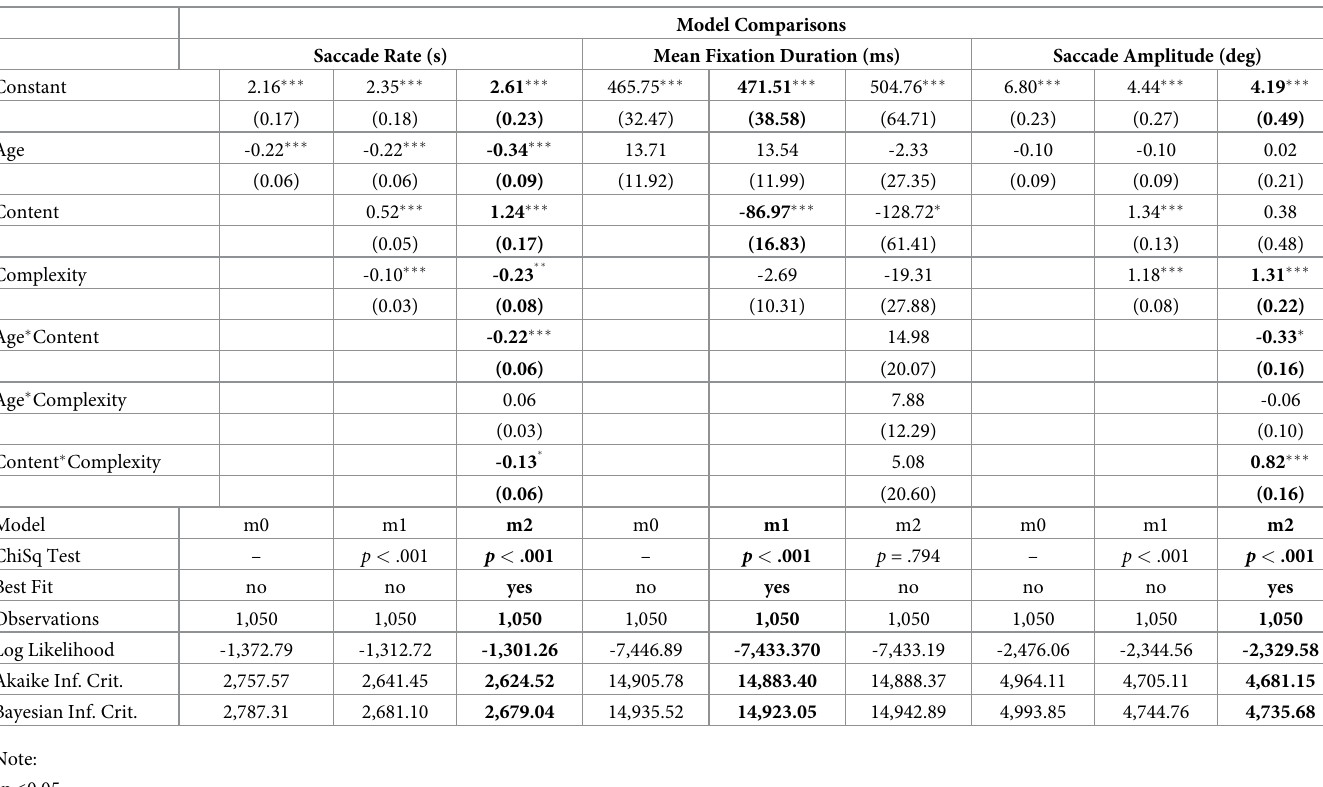
Table 2. Experiment 1 estimates and standard error for all model effects. Significant effects for best-fitting model noted in